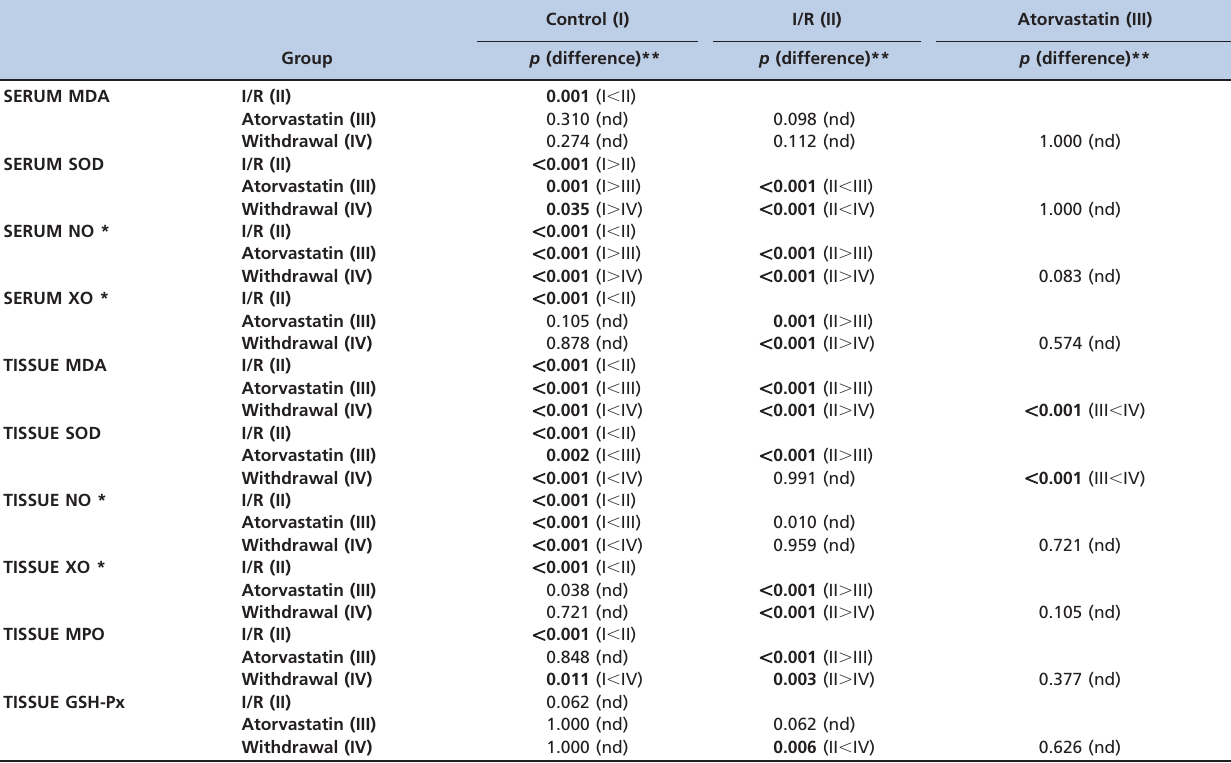
Table 2 - Results of pairwise comparisons of the biochemical markers in the sera and spinal cord tissues of the experimental